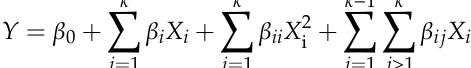
Table S1. Summary of the information of jujube samples; Table S2. Contents ( µ g / g DW) of triterpenic acids in jujube fruit samples; Table S3. Component matrix of principal component